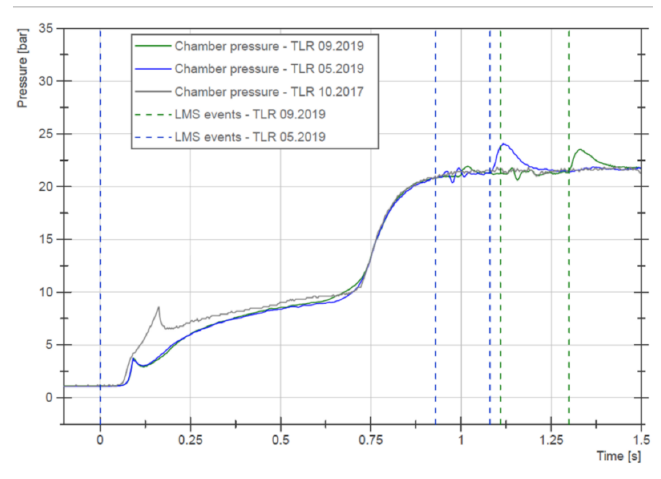
Figure 11. Mobile HTP loading station.